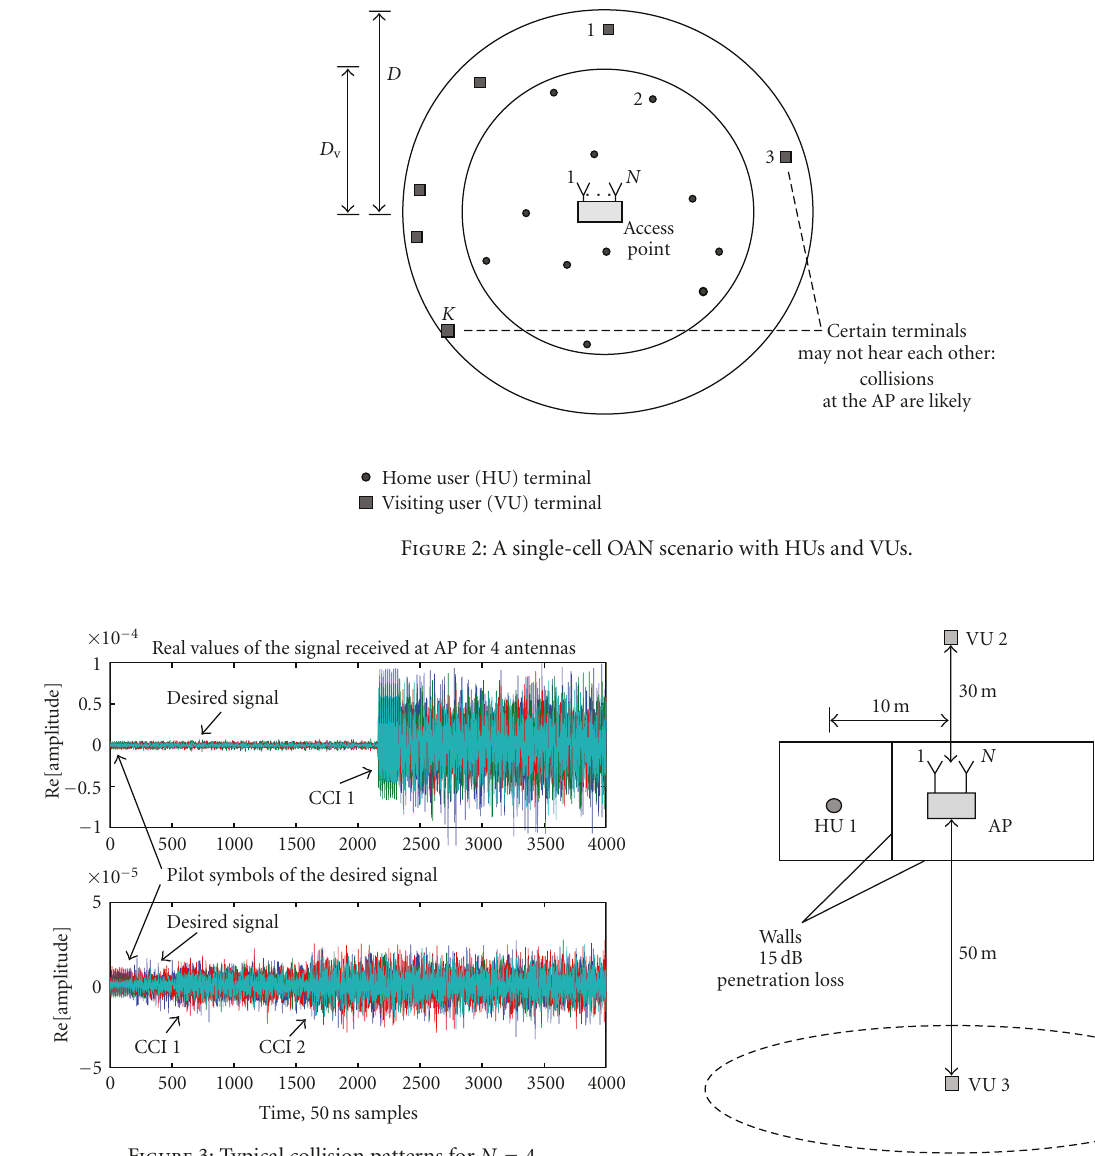
Figure 3: Typical collision patterns for N = 4.